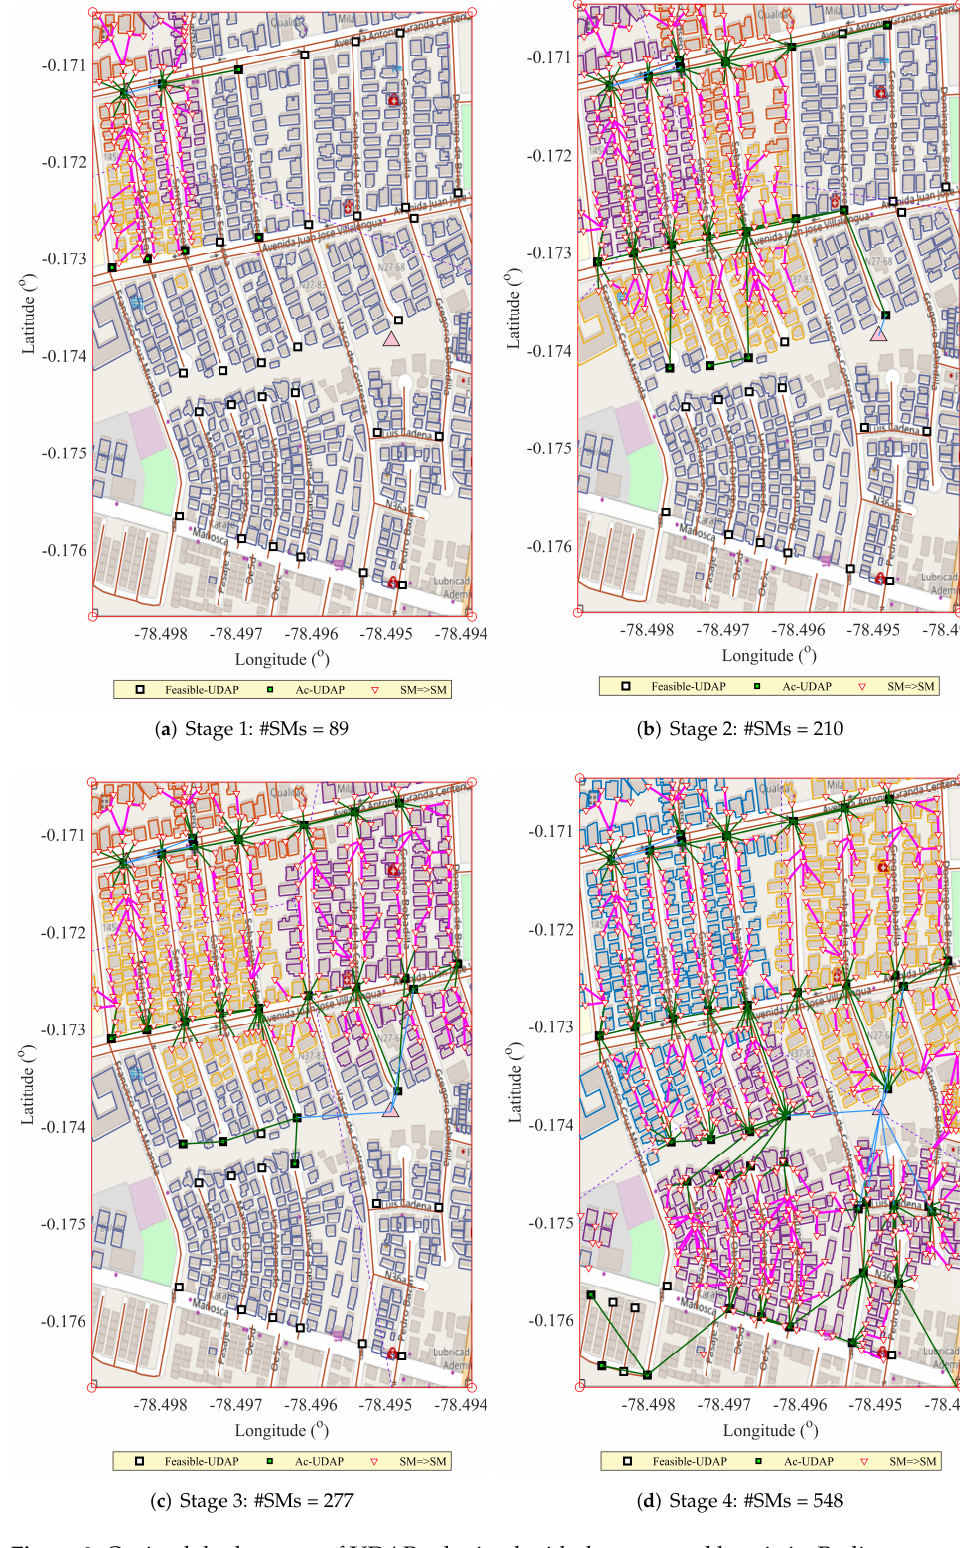
Figure 3. Optimal deployment of UDAPs obtained with the proposed heuristic. Radio coverage = 40 m, UDAP capacity =